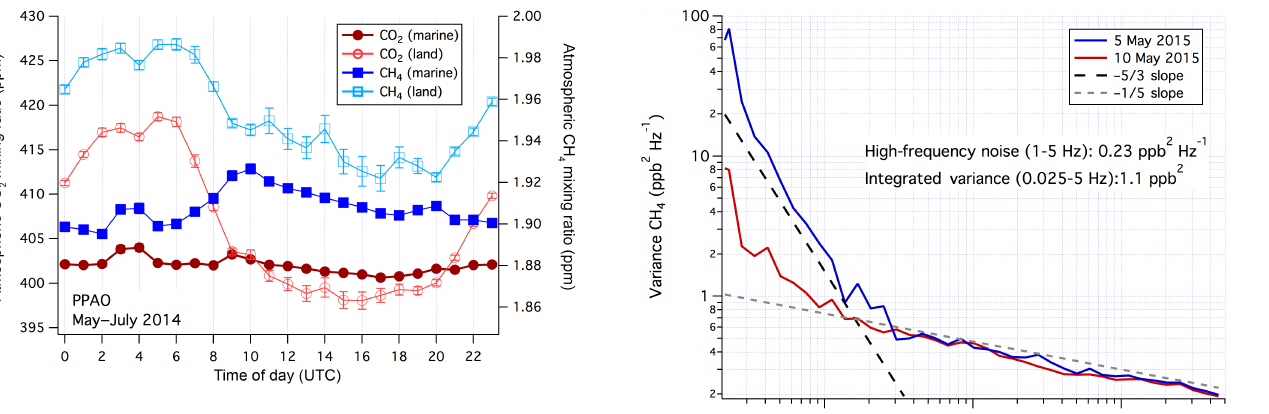
Figure 7. Mean diel cycles in the mixing ratios of CO 2 and CH 4 . Er- ror bars indicate two standard errors within each hour bin. Diel vari- ability for both gases is small during onshore flow (marine winds, 110–240 ◦ ). Mixing ratios of CO 2 and CH 4 during offshore flow (wind from land, 300–60 ◦ ) increase at night and peak in the early morning.